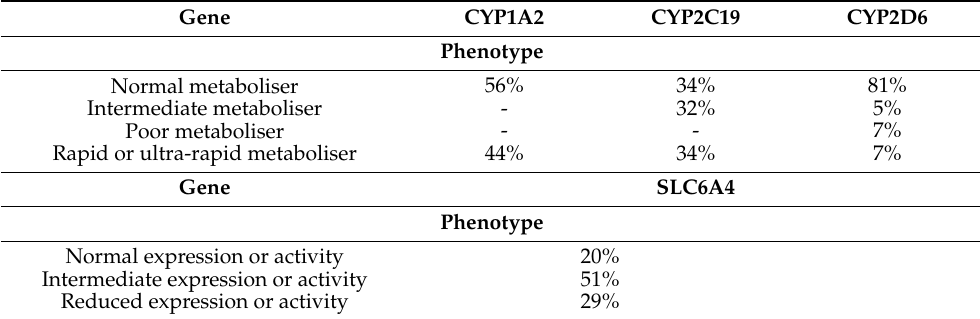
Table 4. Summary of predicted phenotypes observed in treatment-resistant patients.